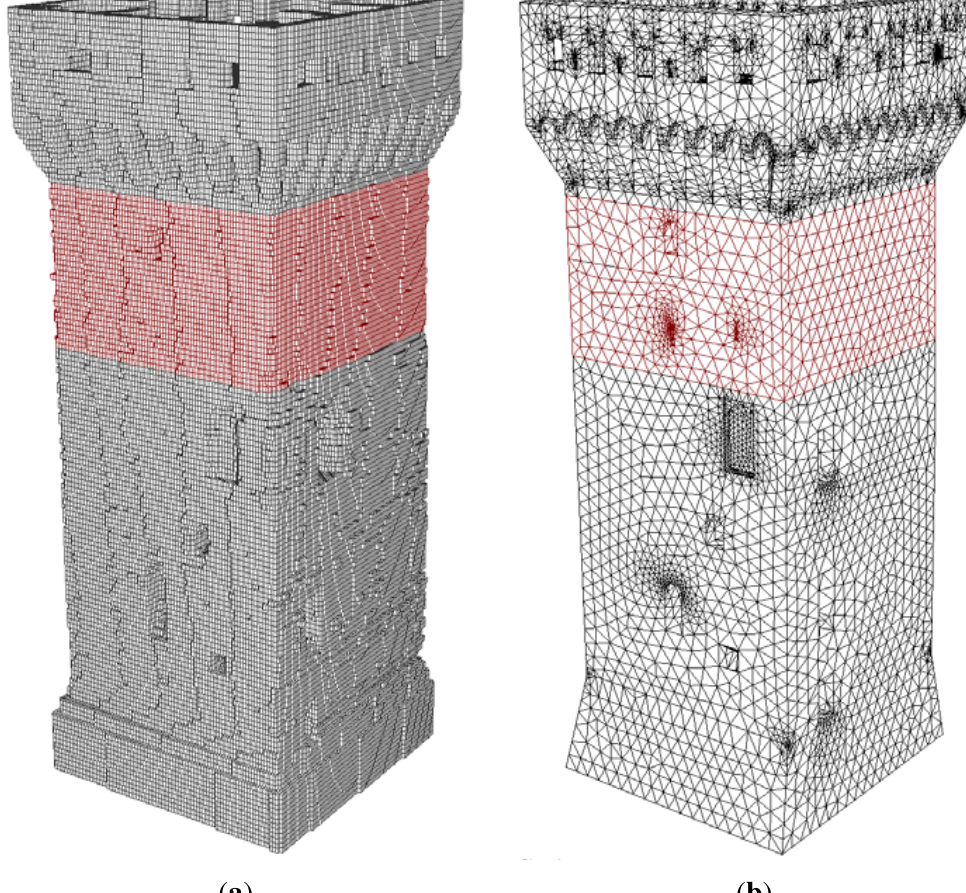
Figure 12. Finite element discretization comparison; colors are set according to the material properties: gray and red colors are used to illustrate the masonry and the reinforced masonry elements, respectively. ( a ) CLOUD2FEM discretization; ( b ) CAD-based